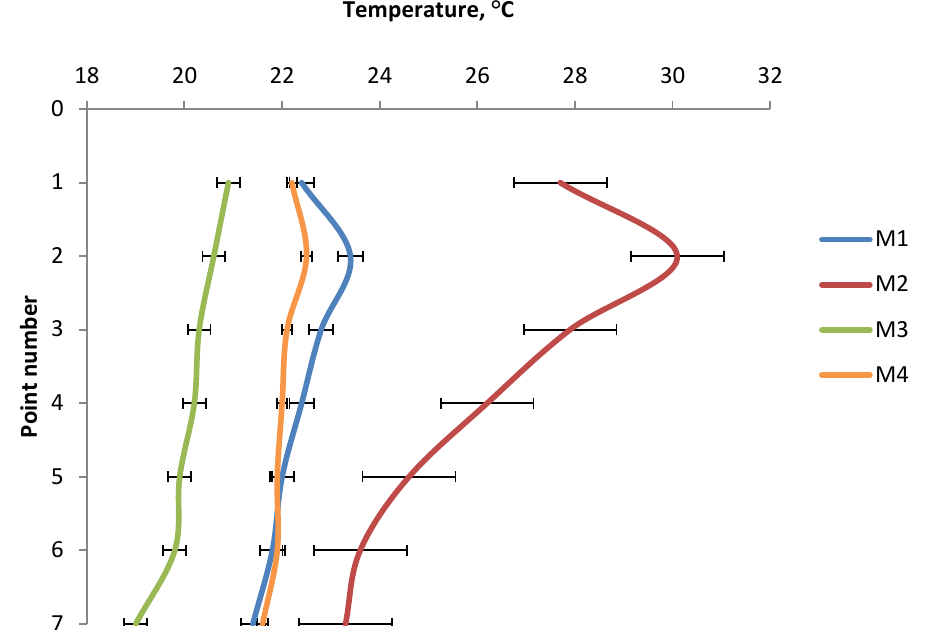
Figure 11. The temperature distribution on the front side of briquette surfaces. From a practical point of view, the best solution would be a situation in which the curves would not be obtained, but lines perpendicular to the temperature axis (X axis), which would mean that the pressure in the entire briquette was equal and the briquettes would have the same physical properties throughout the volume. However, analyzing the obtained results and the curves of temperature variation on the front surface of the briquettes at characteristic points, it can be concluded that the curves of temperature variation for each of the materials from which the briquettes were obtained were similar to each other. Similar to saddle-shaped briquettes [46], the maximum temperature values were obtained in all cases in point 2, except for the M3 mixture, where the temperature reached the maximum value in point 1. This leads to the conclusion that the area of maximum temperature and thus the area of the highest unit pressure was in the upper part of the briquette. This was probably due to the inability of the material to escape from the forming cavities during the roll rotation process and closing the formed volume of material in the forming cavities. The minimum temperature values for each of the briquettes were read for each time in point 7. This led to the conclusion that the place where the pressure took the smallest value was the lower part of the briquette. All curves of temperature variation, except the curve for the M3 mixture, were characterized by an increase in temperature from point 1 to point 2, followed by a linear decrease in temperature to point 7. The lowest temperature values at all points were recorded for briquettes obtained from the M3 mixture—pre-compacted charcoal with the addition of 4% potato starch. The highest temperature values were recorded at all points for the briquette obtained from the M2 mixture of metallurgical scale with a grain size up to 5 mm and with the addition of 4% water. The temperature distribution on the surface of pillow-shaped briquettes correlates with research conducted by other scientists. Hryniewicz proved that the greatest unit pressure was exerted on the pillow-shaped briquette in its upper part [57], while Loginow et al. showed on an experimental stand that the highest deformations of the material occurred in the upper part of this type of briquette [52]. Analyzing the thermograms of briquettes, it can be seen that the highest temperature values were present in one of the upper corners of the briquette, e.g., in Figure 12, in the upper left corner of the briquettes. This proved that the temperature distribution on the briquette surface also depended on the arrangement of other forming cavities on the working surface of the rollers. These briquettes were taken from one and the same row